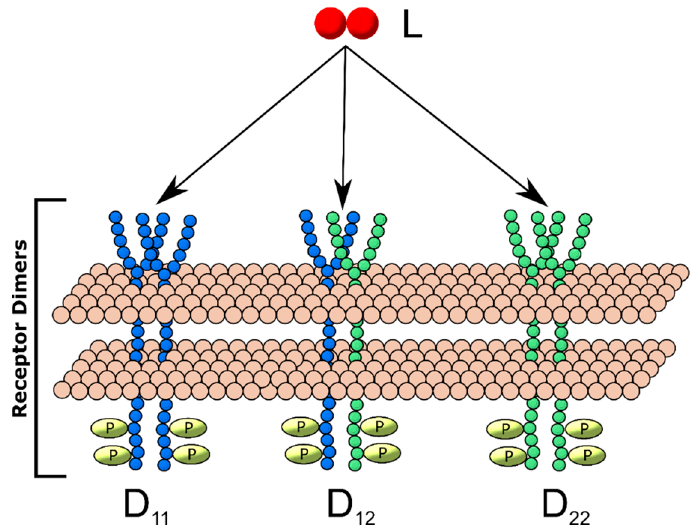
Figure 2. Two-receptor, one-ligand (2R1L) dimerization model schematic. Two receptor monomers, R 1 (blue) and R 2 (red), bind ligand L and form dimers D ij , where i and j represent receptor monomers. Thus, D 11 is a homodimer containing two R 1 , D 12 is a heterodimer containing one R 1 and one R 2 and D 22 is a homodimer containing two R 2 .